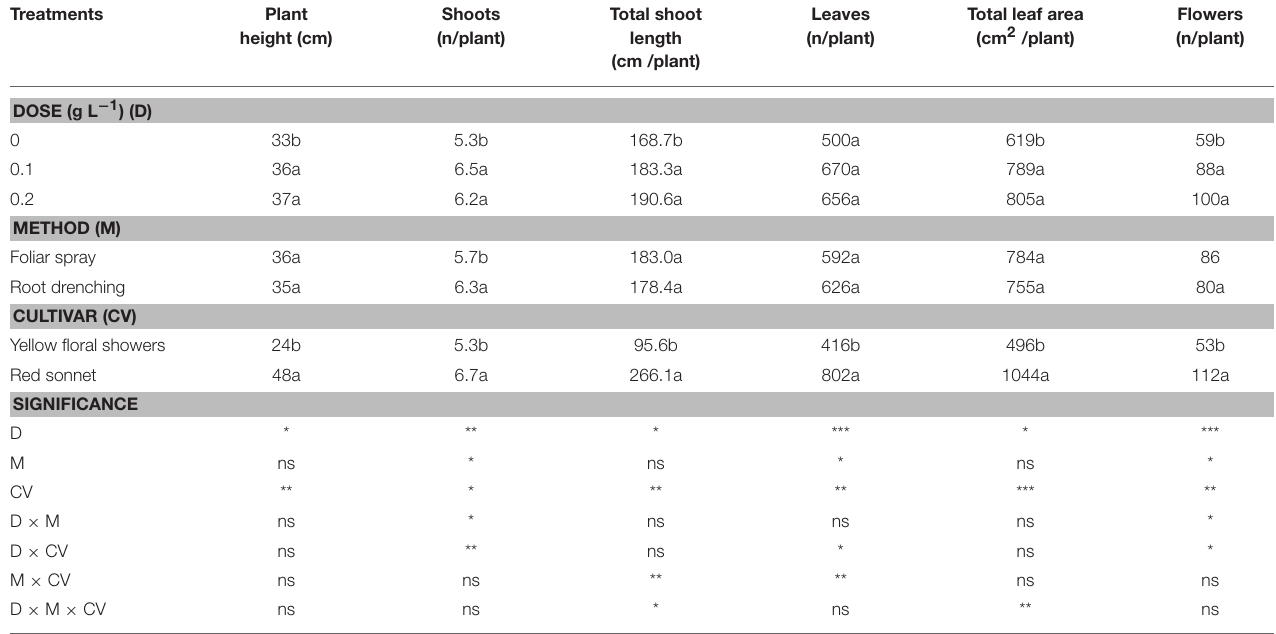
TABLE 2 | Main effects of biostimulant dose, application method and cultivar on plant height, shoot number, total shoot length, leaves number, total leaf area, and flowers number in snapdragon plants. Treatments Plant